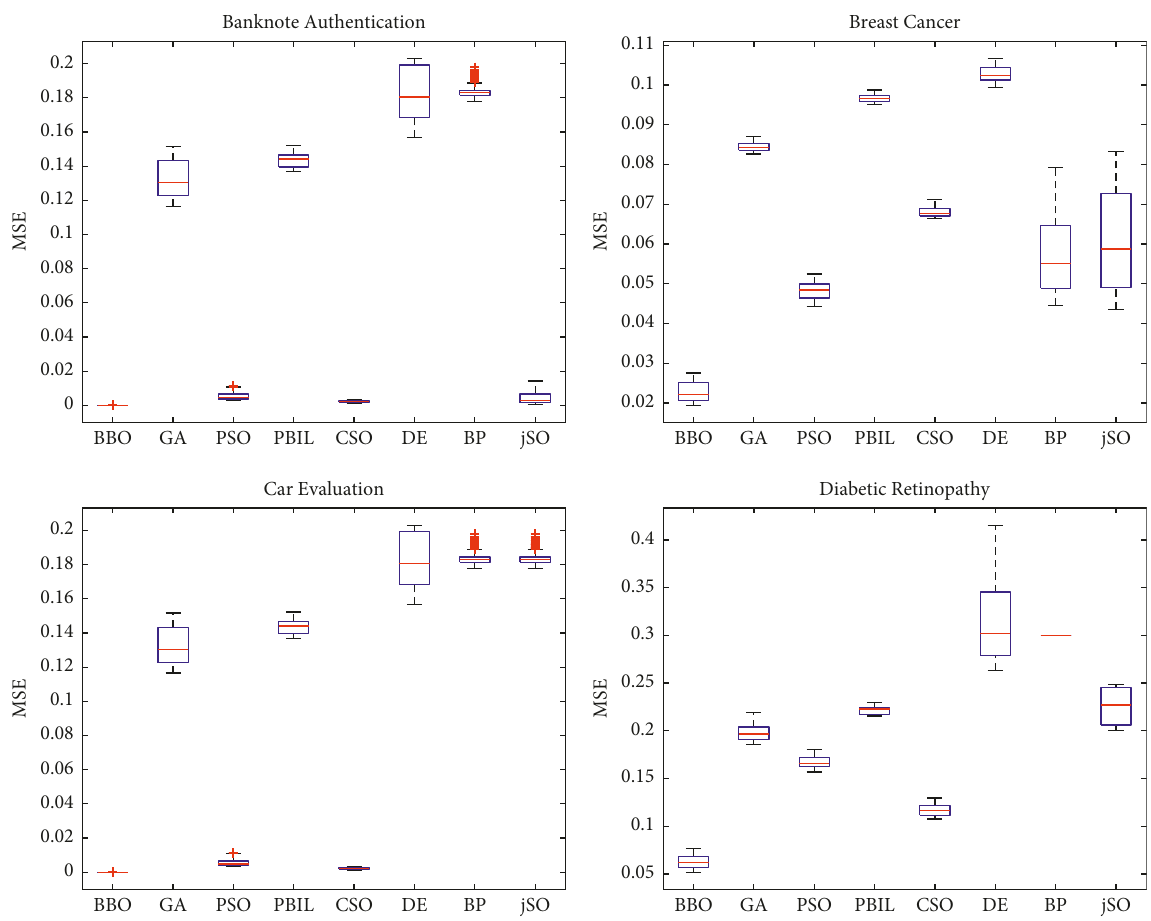
Figure 4: Solution distribution of DNM for the datasets of banknote authentication, breast cancer, car evaluation, and diabetic retinopathy,